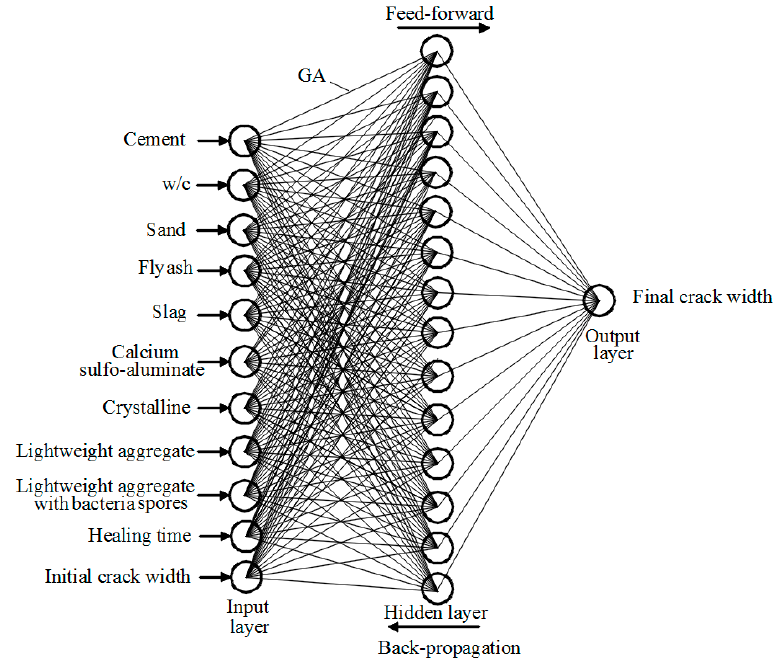
Figure 2. Architecture of genetic algorithm–artificial neural network (GA–ANN) model.